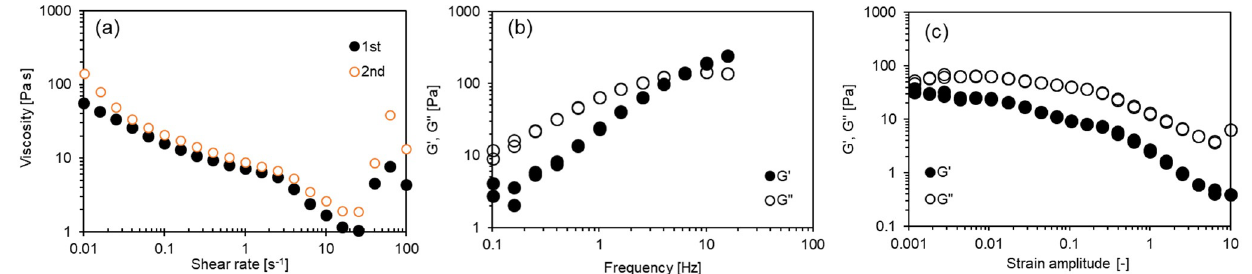
Figure 3. Viscosity, storage modulus ( G ’), and loss modulus ( G ”) of climbing colloidal suspension of 70 wt. % silica particles of 1.0 μ m diameter and water: ( a ) viscosity against shear rate, ( b ) G ’ and of 70 wt. % silica particles of 1.0 µ m diameter and water: ( a ) viscosity against shear rate, ( b ) G (cid:48) and G ” against frequency at a strain amplitude of 0.01, and ( c ) G ’ and G ” against strain amplitude at a G (cid:48)(cid:48) against frequency at a strain amplitude of 0.01, and ( c ) G (cid:48) and G (cid:48)(cid:48) against strain amplitude at a frequency of 1 Hz. frequency of 1